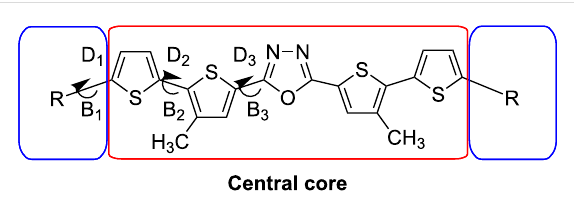
Figure 3: General structure of 5'-aryl-substituted 2,5-bis(3-decyl-2,2'- bithiophen-5-yl)-1,3,4-oxadiazoles.